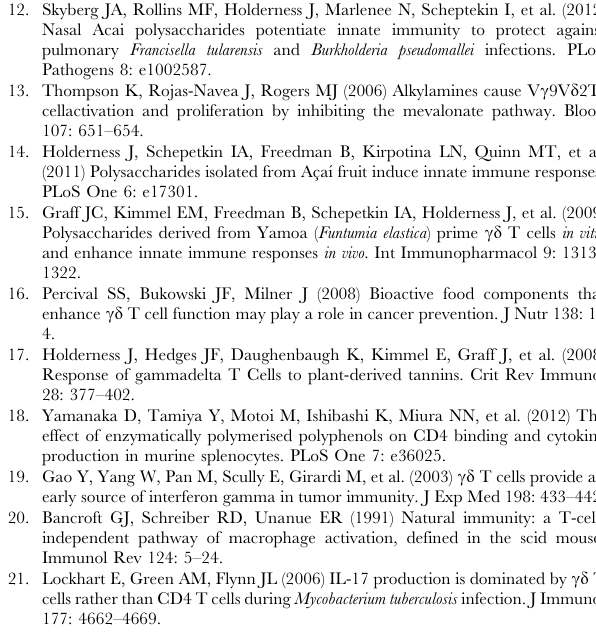
Figure S1 Oenothein B induces IL-2R a or CD69 on bovine and human NK cells. (A) Bovine PBMCs (10 5 cells/ well) were treated with 20 m g/ml oenothein B in X-VIVO medium for 24 hrs, and IL-2R a expression on NK cells was